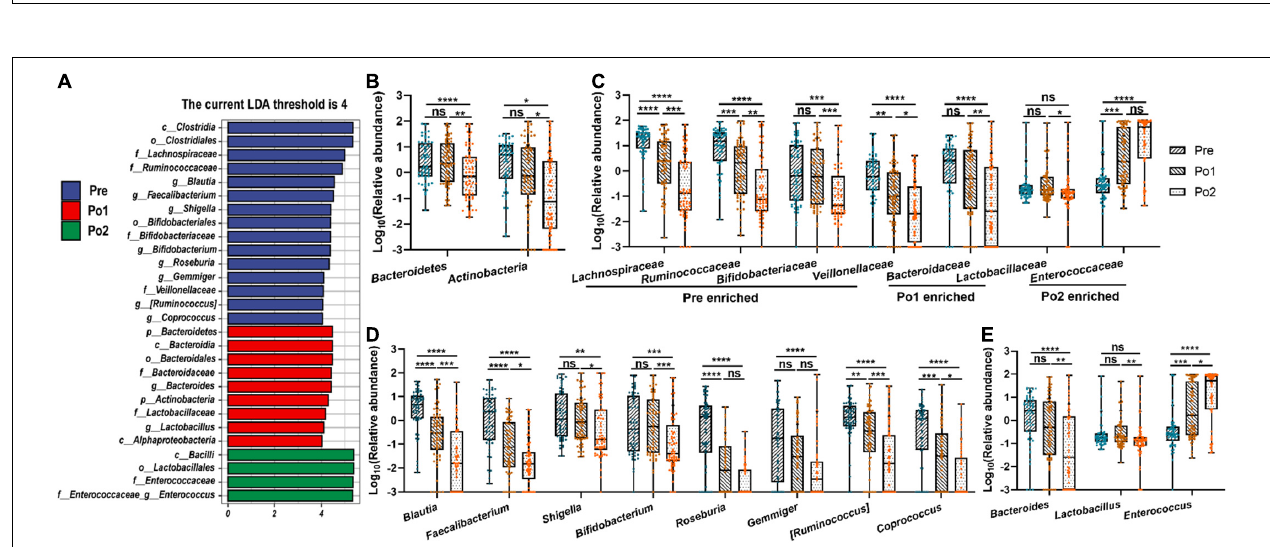
FIGURE 6 | Microbial differential analysis and changes of specific bacterial taxa. Linear discriminant analysis coupled with effect size analysis (A) and comparison of representative taxonomic abundance in phylum (B) , family (C) , and genus level (D,E) were assessed across time series. LDA discriminant bar counts biomarkers with significant effects in different groups with an LDA score greater than 4. Statistical assessment was carried out with one-way analysis of variance or Kruskal–Wallis test for parametric or non-parametric data followed by post hoc test using Dunn’s multiple comparison test. P < 0.05 indicates statistical significance (* P < 0.05, ** P < 0.01, *** P < 0.001, and **** P < 0.0001), and ns means P > 0.05. Results are expressed as median and quartile.